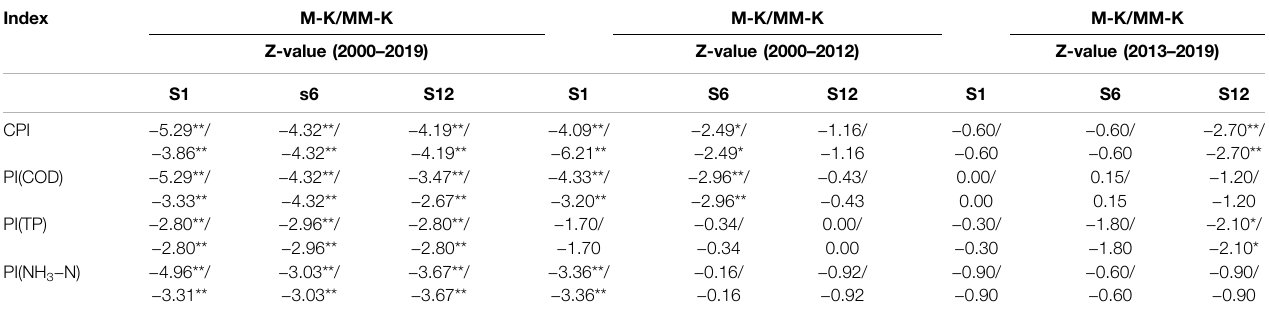
TABLE 2 | Mann-Kendall test for the CPI and single PIs in the river estuaries (* and** indicate signi fi cant correlation at the α = 0.05 and 0.01 levels,